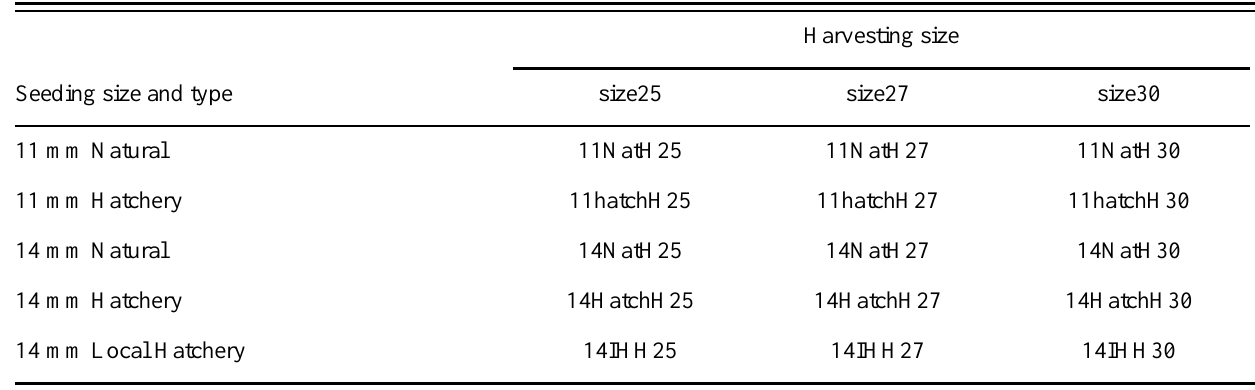
Table 4. Description of the (15) scenarios simulated for each of the four lagoon area